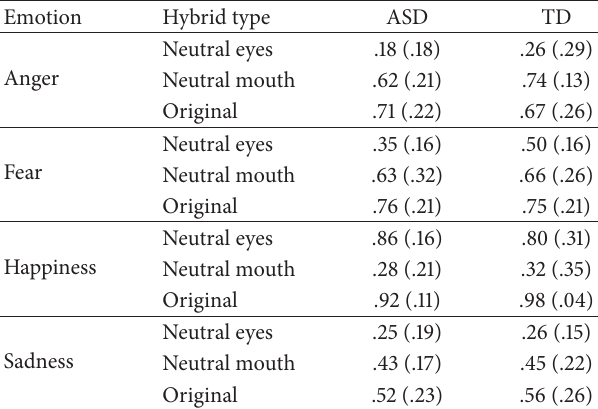
Table 3: Accurate labeling of the hybrid expressions for both participant groups: mean accuracy and standard deviation (between